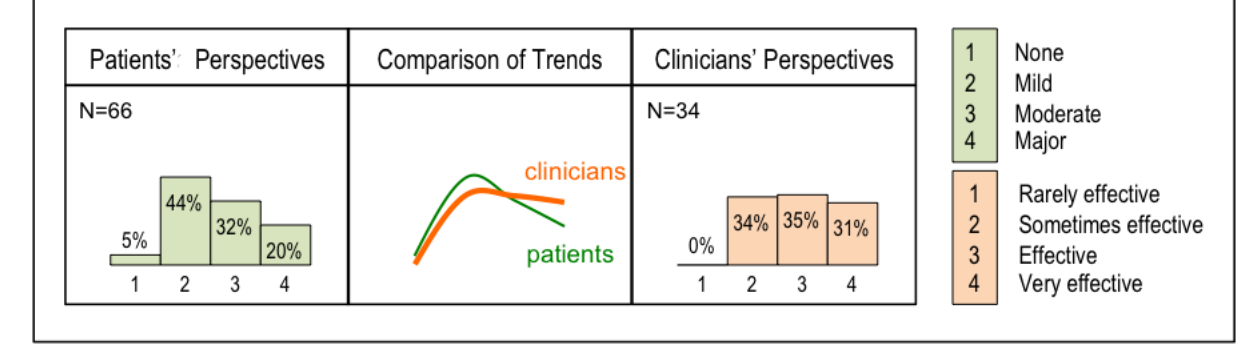
Figure 3. Perceived efficacy of baclofen to treat spasticity and